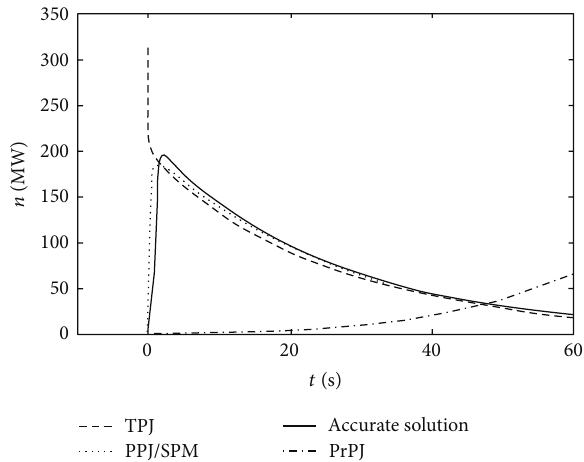
Figure 6: Variation of output power with time while inserting step reactivity 0.998𝛽